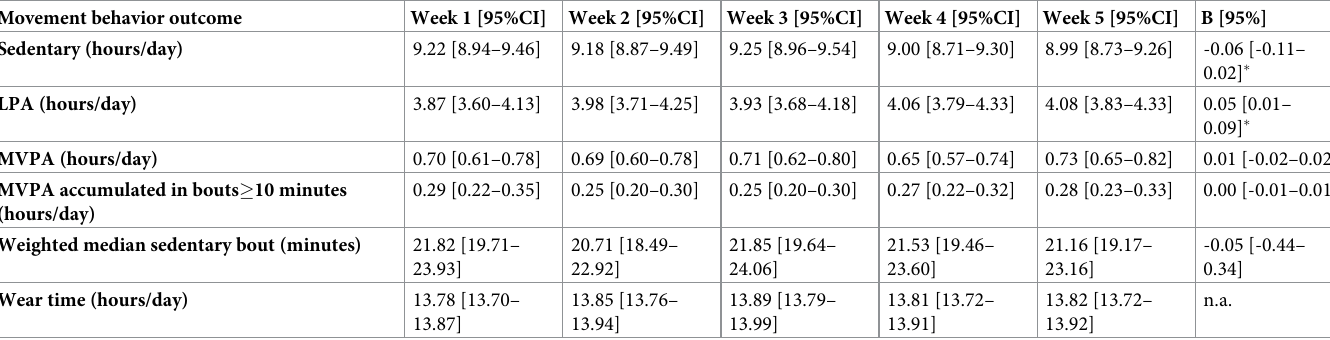
Table 2. Movement behavior outcomes in the overall group and generalized estimating equations analyses adjusted for wear time. Movement behavior outcome